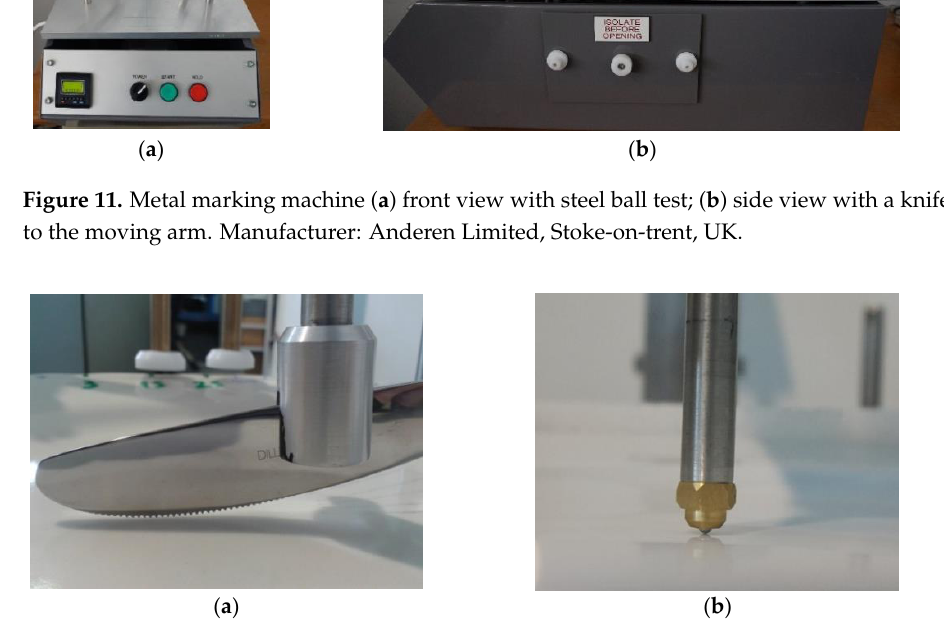
Figure 13. Spheres wear after the metal marking test ( a ) AISI 304 and ( b ) AISI 420.